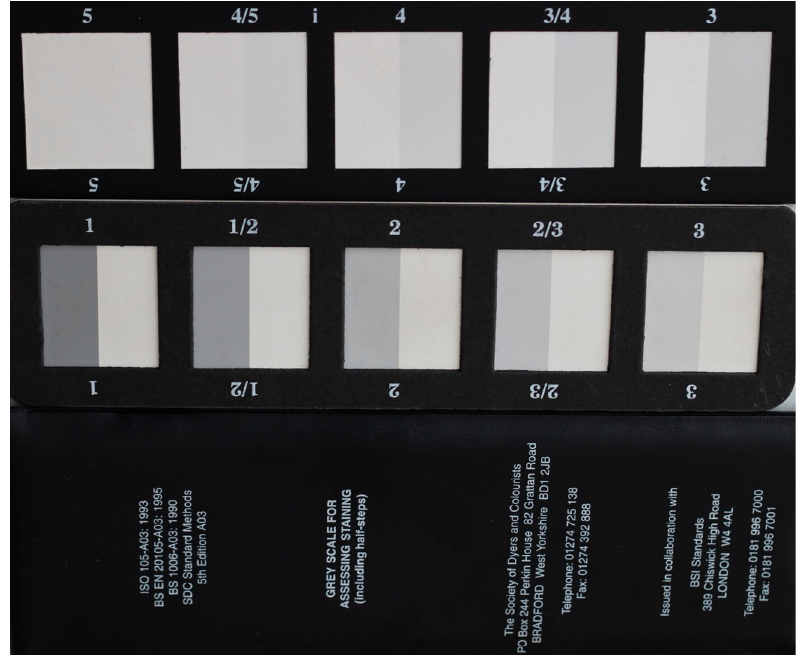
Figure 3. Greyscale (ISO 105 A03 BS 1006